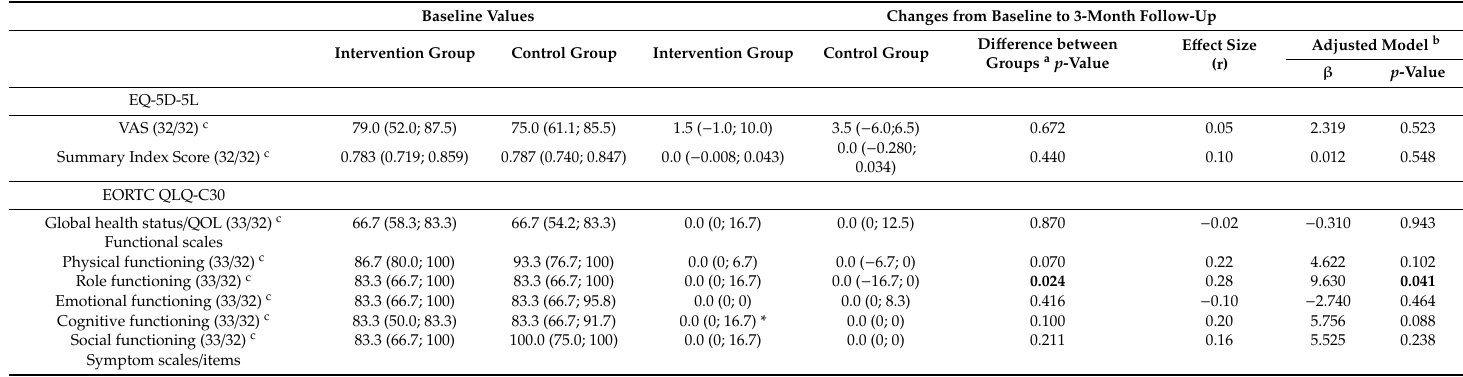
Table 4. Changes in health-related quality of life and symptoms of anxiety and depression from baseline to 3-month follow-up in the NUTRI-HAB trial. Baseline Values Changes from Baseline to 3-Month